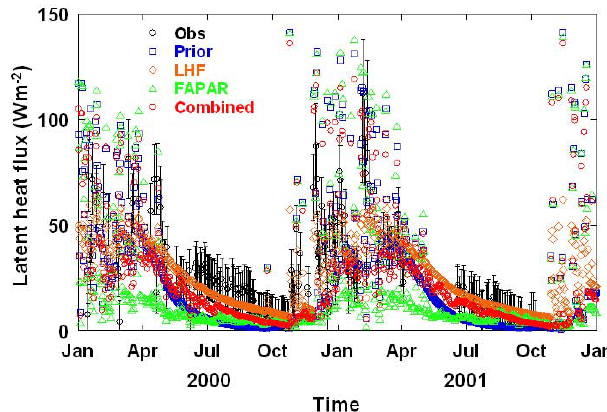
Fig. 3. Daily observed and simulated latent heat flux (LHF; Wm − 2 ) for the years 2000–2001. The error bar for observed LHF (Obs) rep- resents the data uncertainty used in CCDAS. “Prior”, “LHF”, “FA- PAR”, and “Combined” are prior run and posterior runs with LHF, FAPAR, and combined LHF and FAPAR, respectively. Root mean square errors (RMSEs) of simulated LHF against observations are 23.5, 14.3, 27.3 and 21.5Wm − 2 for Prior, LHF, FAPAR, and Com- bined assimilations, respectively.